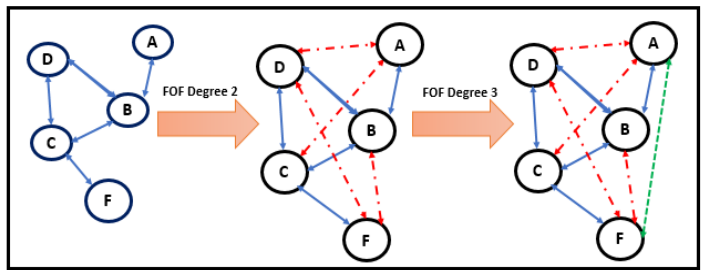
Figure 6. Newly generated social network with added virtual